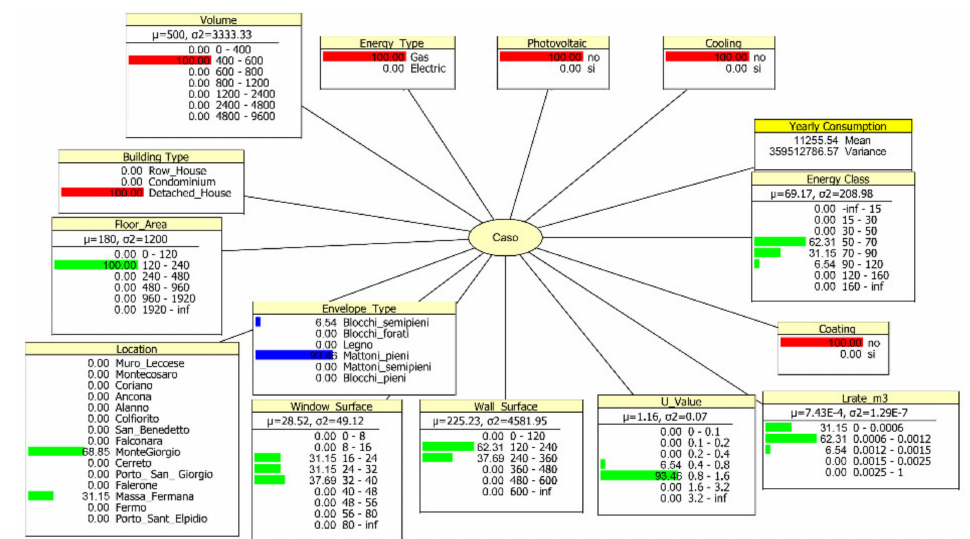
Figure 23. Fixing neighborhood cases and scenario analysis.